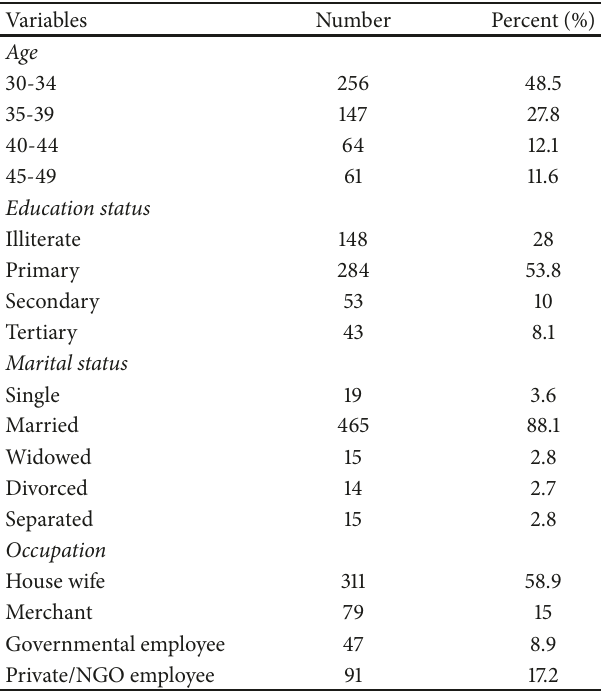
Table 1: Sociodemographic characteristics of women screened for precervical cancer in Arba Minch town and zuria district, Gamo Gofa zone, SNNPR, Ethiopia, 2017.